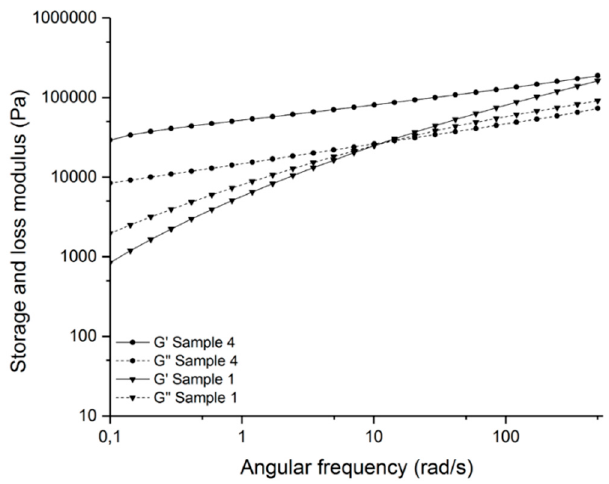
Figure 6. Storage and loss moduli (G’ and G’’) of the crosslinked sample (sample 4) and the non-crosslinked sample (sample 1).